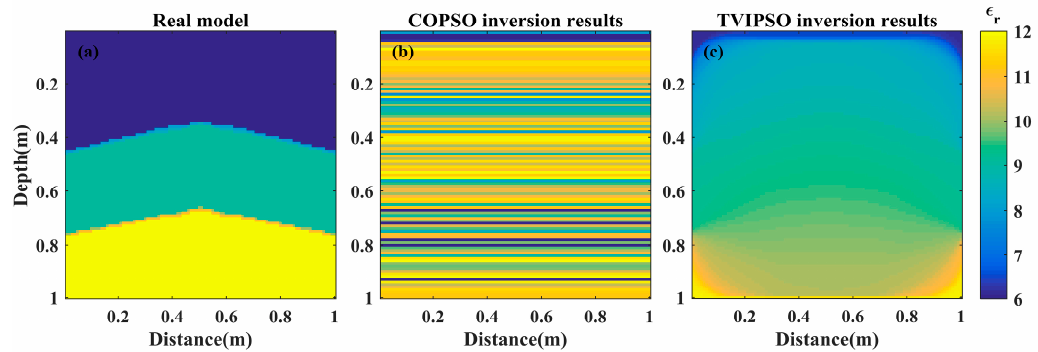
Figure 6. Different models and results: ( a ) real model; ( b ) COPSO inversion results; ( c ) TVIPSO inversion results using the random-layered initial model.